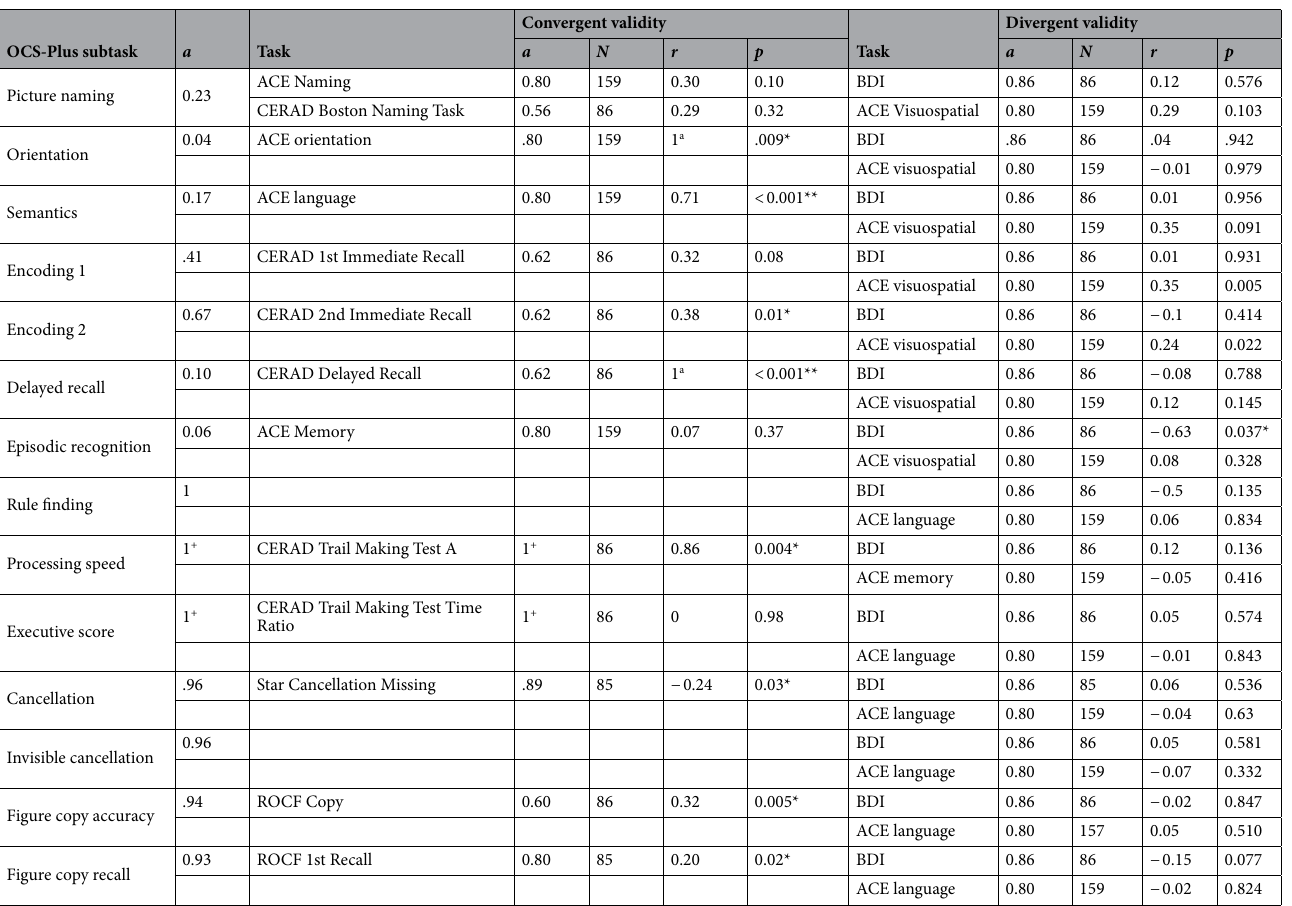
Table 7. Convergent and divergent correlational analysis (with coefficients correct for internal consistency) of the OCS-Plus sub-tasks. OCS‑Plus Oxford Cognitive Screen-Plus, r Kendall correlation, BDI